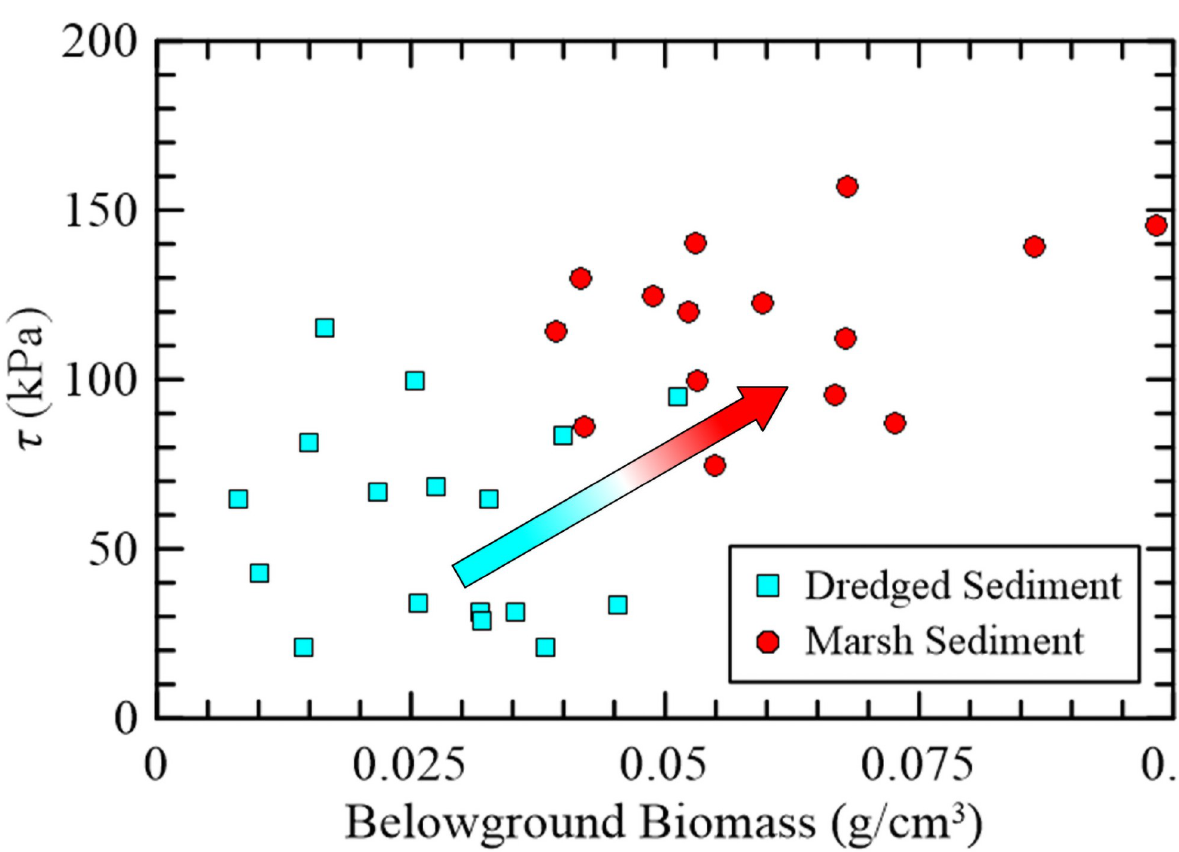
Fig 10. Shear strength compared to belowground biomass measurements within the dredged sediment and marsh sediment samples. Arrow illustrates the trajectory of dredged sediment to established marsh sediment.